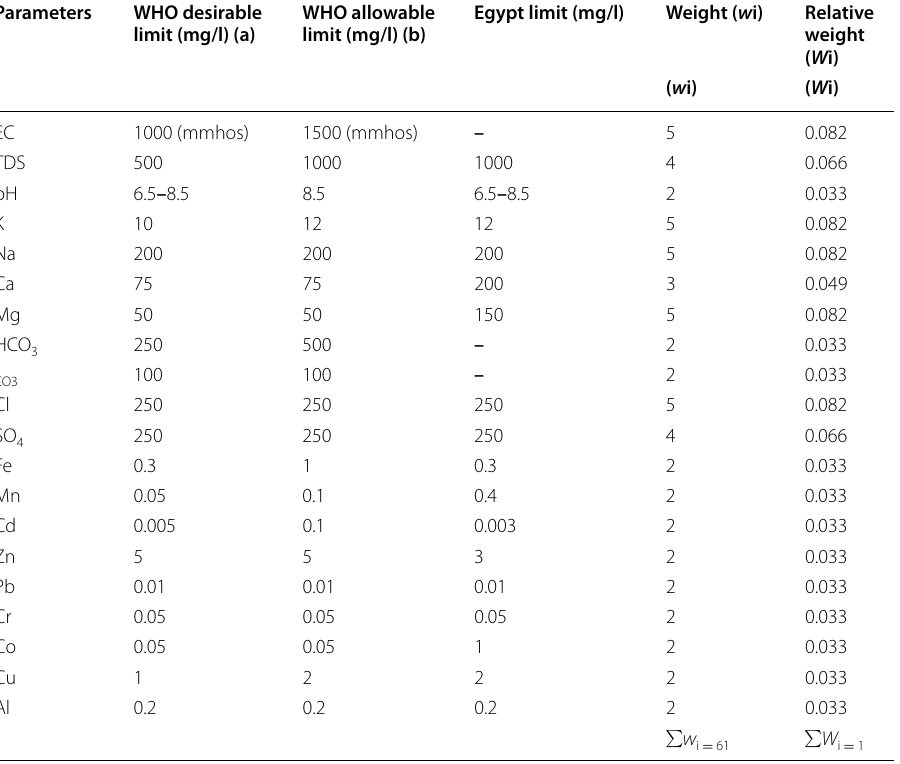
Table 2 Limits of WHO, Egyptian standards and assigned weight, and relative for chemical parameters